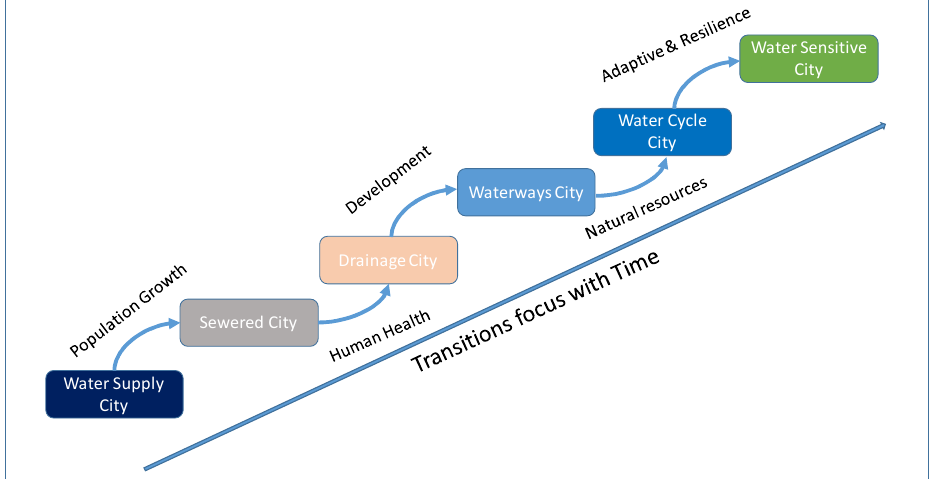
Figure 3. Changing paradigms of Water Security and Transition Phase for cities (adapted from brown et al. 2008 [22]).